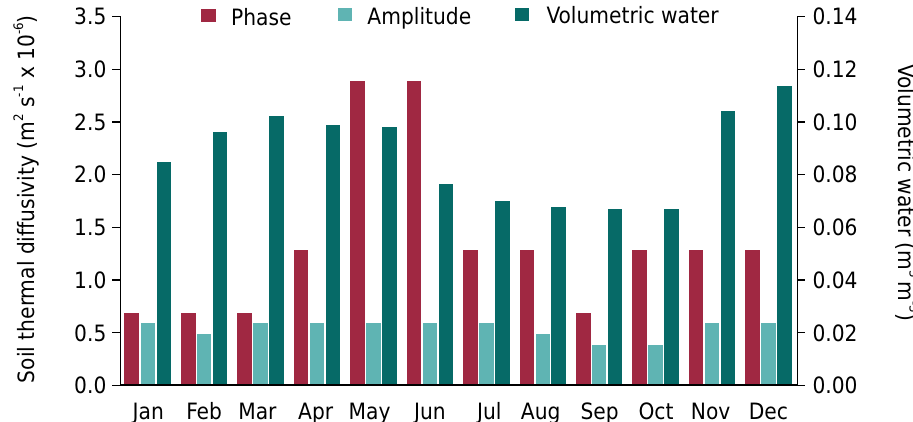
Figure 6. Monthly means of soil thermal diffusivity at the 0.05 and 0.20 m depths of a Cambissolo Háplico Ta Eutrófico (Cambisol; Inceptisol) estimated based on soil temperature data recorded from February 04, 2014, to September 30, 2015, in São Gabriel, Irecê Identity Territory, Bahia, Brazil.